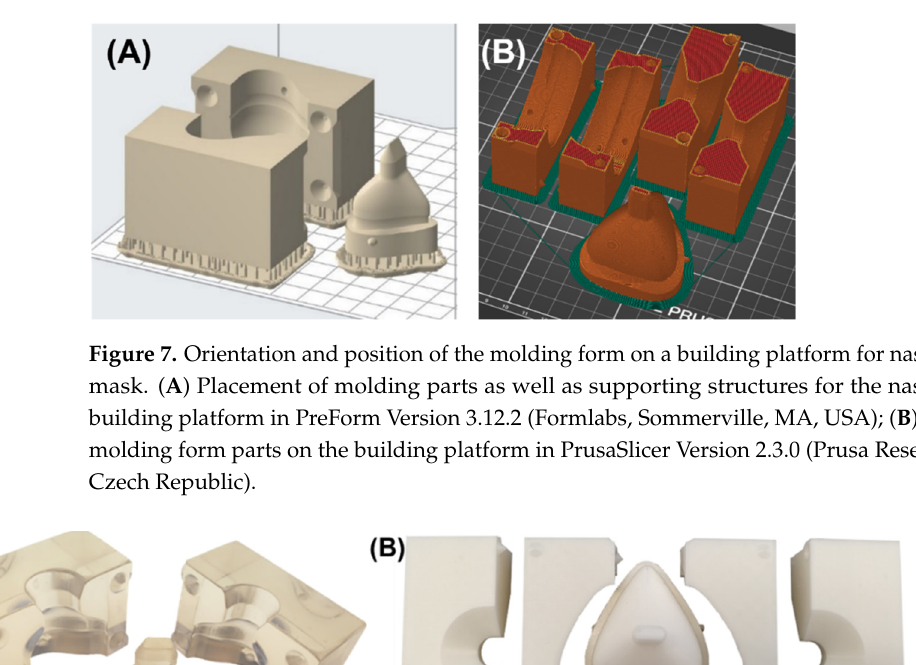
Figure 7. Orientation and position of the molding form on a building platform for nasal and oronasal mask. ( A ) Placement of molding parts as well as supporting structures for the nasal mask on the building platform in PreForm Version 3.12.2 (Formlabs, Sommerville, MA, USA); ( B ) Oronasal mask molding form parts on the building platform in PrusaSlicer Version 2.3.0 (Prusa Research a.s., Praha, Czech Republic).